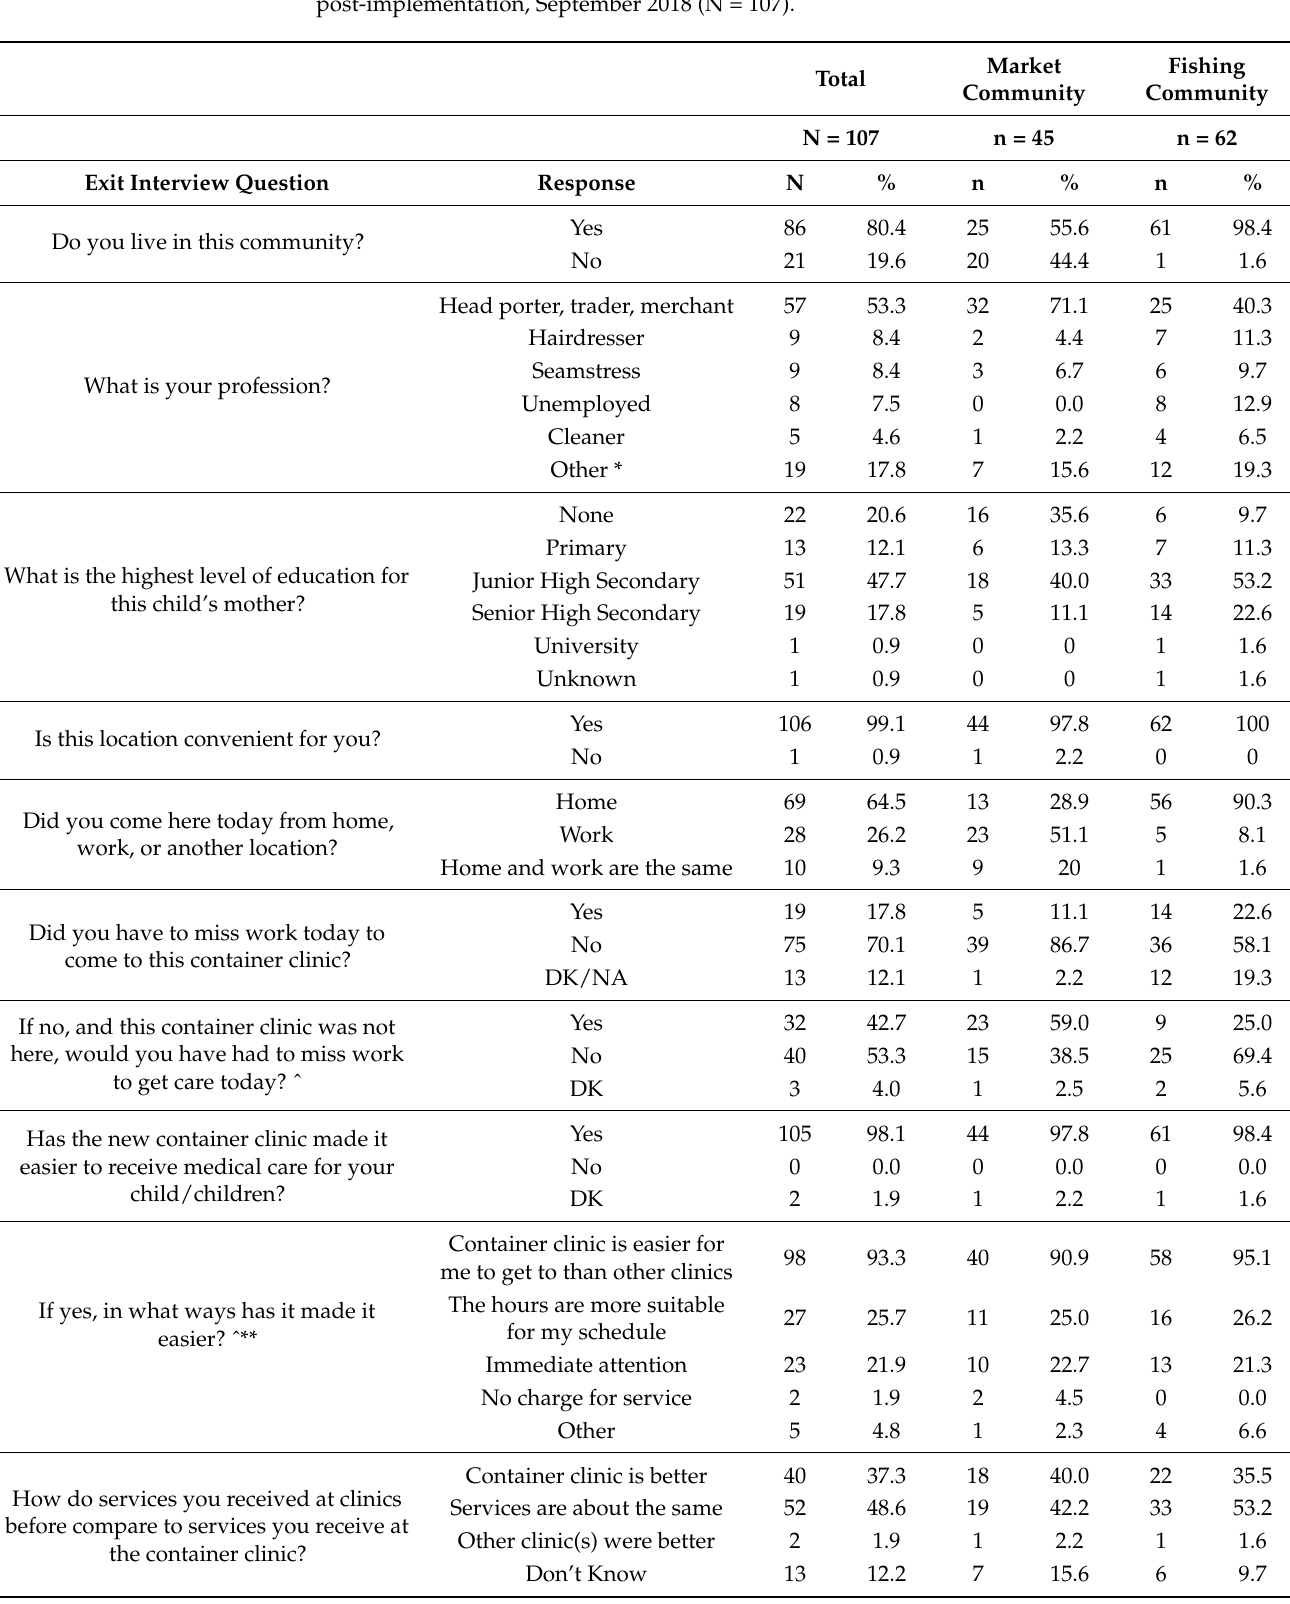
Table 1. Exit interview responses among caregivers of children 0–5 years of age from container clinics in two urban communities on the accessibility and acceptability of services offered 12 months post-implementation, September 2018 (N = 107).